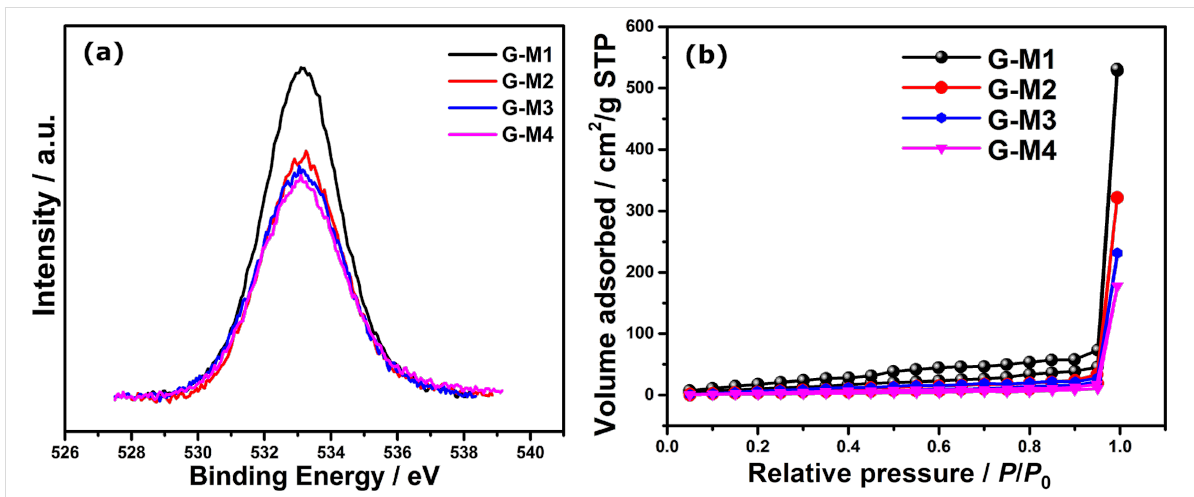
Figure 1: (a) High resolution O 1s XPS spectra of different EEG samples. (b) BET isotherms of different EEG samples.